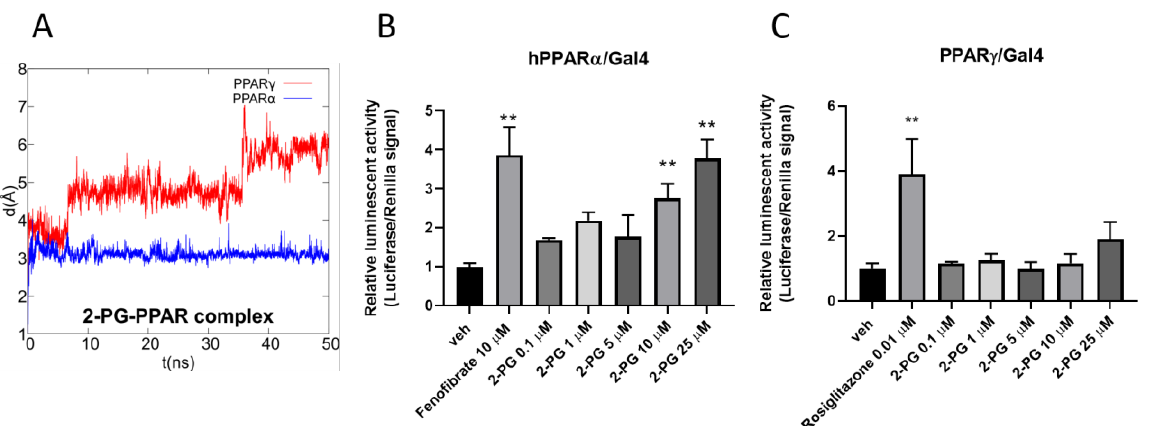
Figure 5. ( A ) Root-mean-square deviation (RMSD) plot of 2-PG in complex with PPAR α / γ over the 50 ns of molecular dynamics (MD) trajectory after best fitting of protein backbones. Luciferase assays performed in PPAR α - or PPAR γ -transfected COS cells ( B , C ). Bar graphs showing the ratio between firefly and Renilla luciferase in response to increasing concentrations of 2-PG. Fenofibrate and rosiglitazone were used as positive controls for PPAR α ( B ) and PPAR γ ( C ), respectively. The vehicle group was set to 1; thus, the relative luciferase activities obtained for each tested compound and concentration are presented as fold induction in comparison to the vehicle control. Each point is the mean ± SEM of four separate determinations performed in duplicate. The double asterisk denotes a p -value ≤ 0.005 versus the vehicle group.